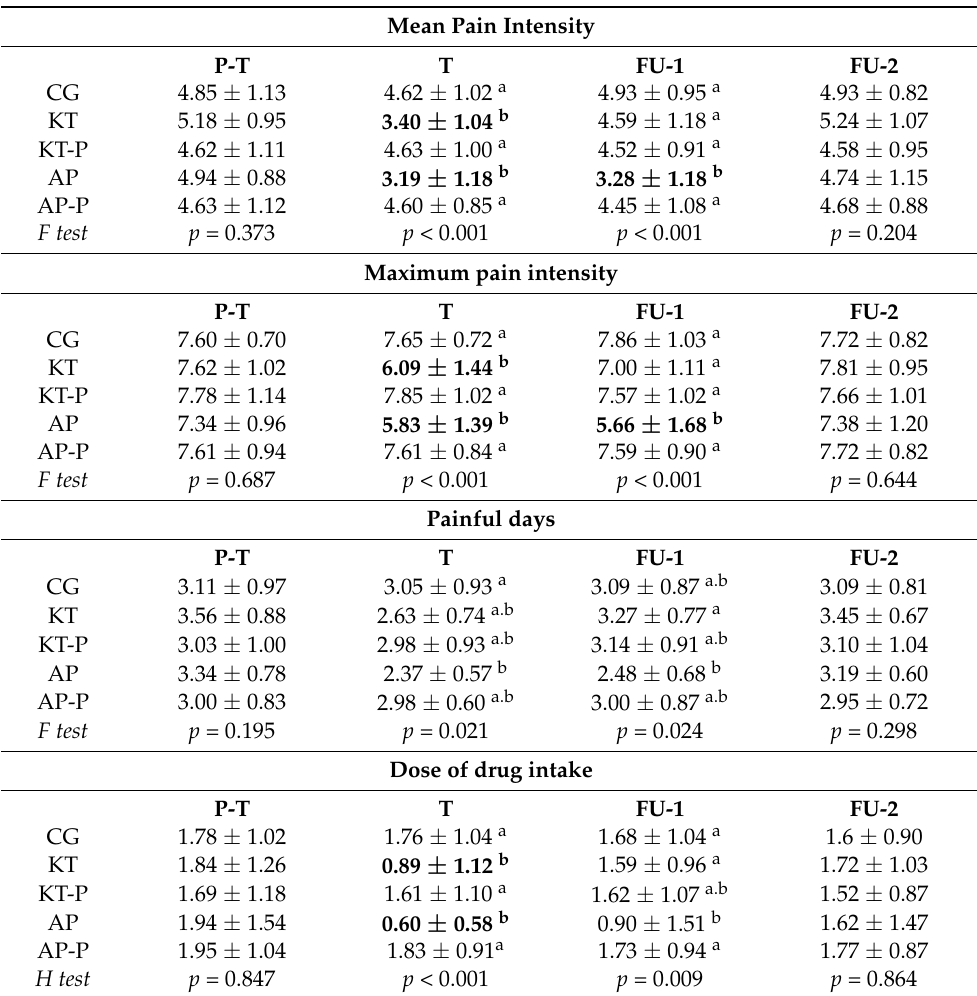
Table 2. Changes (mean ± SD) of the primary outcome measures by groups along the four phases. SD: standard